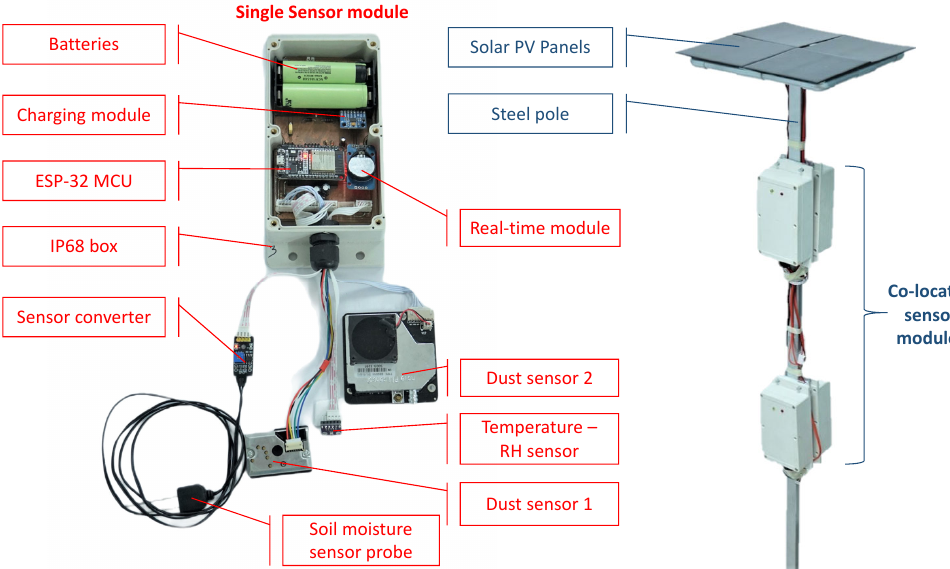
Figure 1. Prototype of a sensor module ( left ) connected with multiple low-cost sensors and a sensor mote ( right ) including four collocated sensor modules attached on the steel pole with 4 mini solar PV